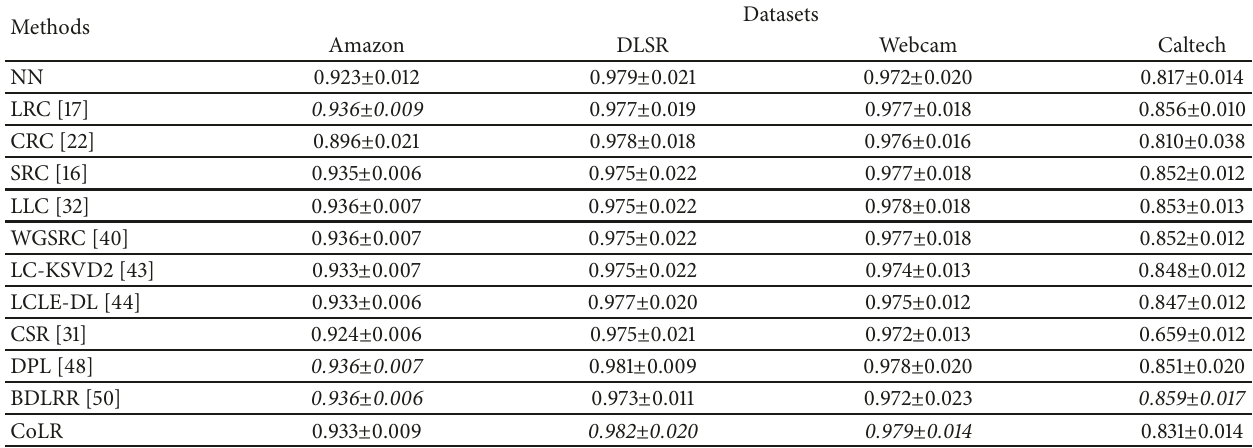
Table 10: Recognition rates of each method on 4DA datasets using 𝑓 6 CNN-layer features.